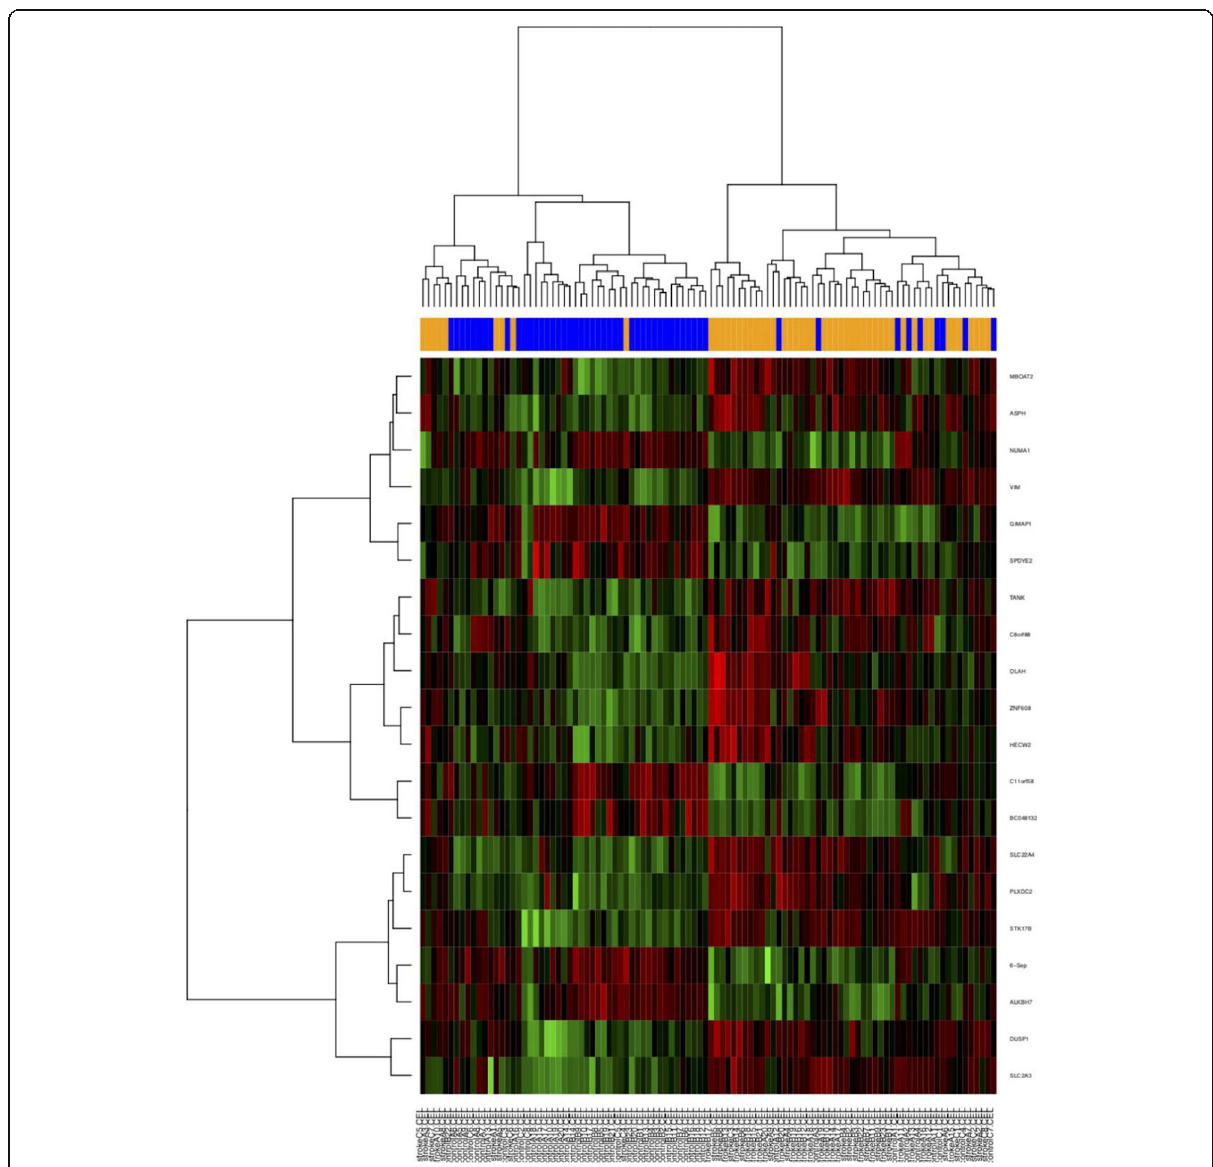
Fig. 3 Heatmap of the top 20 differentially expressed genes (for the sake of space, only a portion of the figure is shown